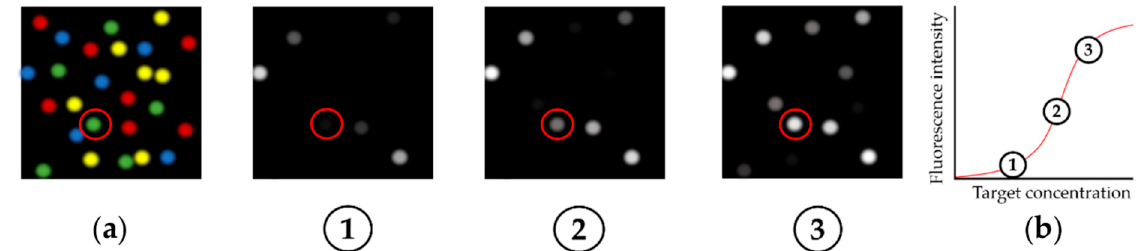
Figure 1. Schematic representation of the fluorescence signals detected in HiTS–FLIP and the resulting binding curve. First, sequencing by synthesis was carried out ( a ), whereby the positions of the clusters and their sequences were known. Subsequently, a fluorescence-labelled target was added to the flow cell in different concentrations and the fluorescence intensity was determined for each cluster, depending on the target concentration ( 1 , 2 , and 3 ). By fitting a sigmoidal function to this data, a binding curve could be generated for each cluster (exemplarily shown for the red-circled cluster, ( b ).